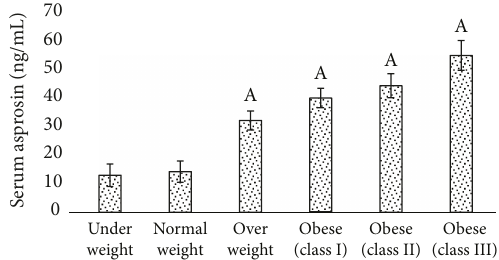
Figure 1: Comparison of blood asprosin values of underweight, normal weight, and overweight individuals and participants with classes I, II, and III obesity. a Normal weight versus another group ( p < 0 005 ).